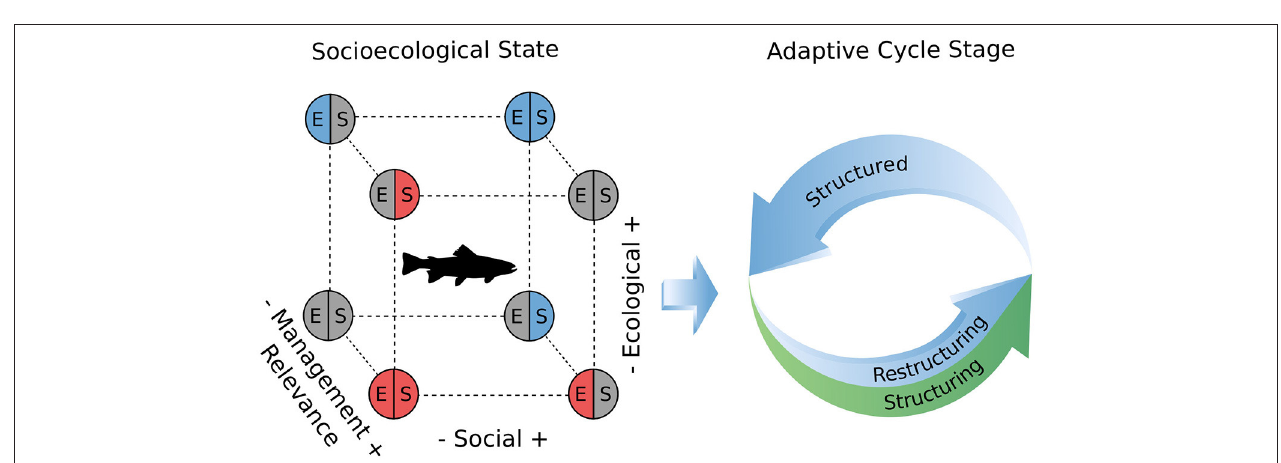
FIGURE 2 | Evaluating the system state with respect to a focal species once the node determining the nature of the action needed to maintain resilience in management is determined. The relevance of the species will fall along a spectrum (– to + ) and can then be evaluated with respect to the spectrum of social (S) and ecological (E) forces (– to + ). Systems are not stationary, and the malleability of the system state to management actions depends on the resilience stage (structuring, structured, restructuring) within the adaptive cycle. At the extremes, the nodes indicate the management action required to enhance resilience, with gray indicating no action, blue indicating management actions aimed at reducing the forcing component, and red indicating management actions aimed at enhancing the forcing component. The final options for management will depend on the system state.